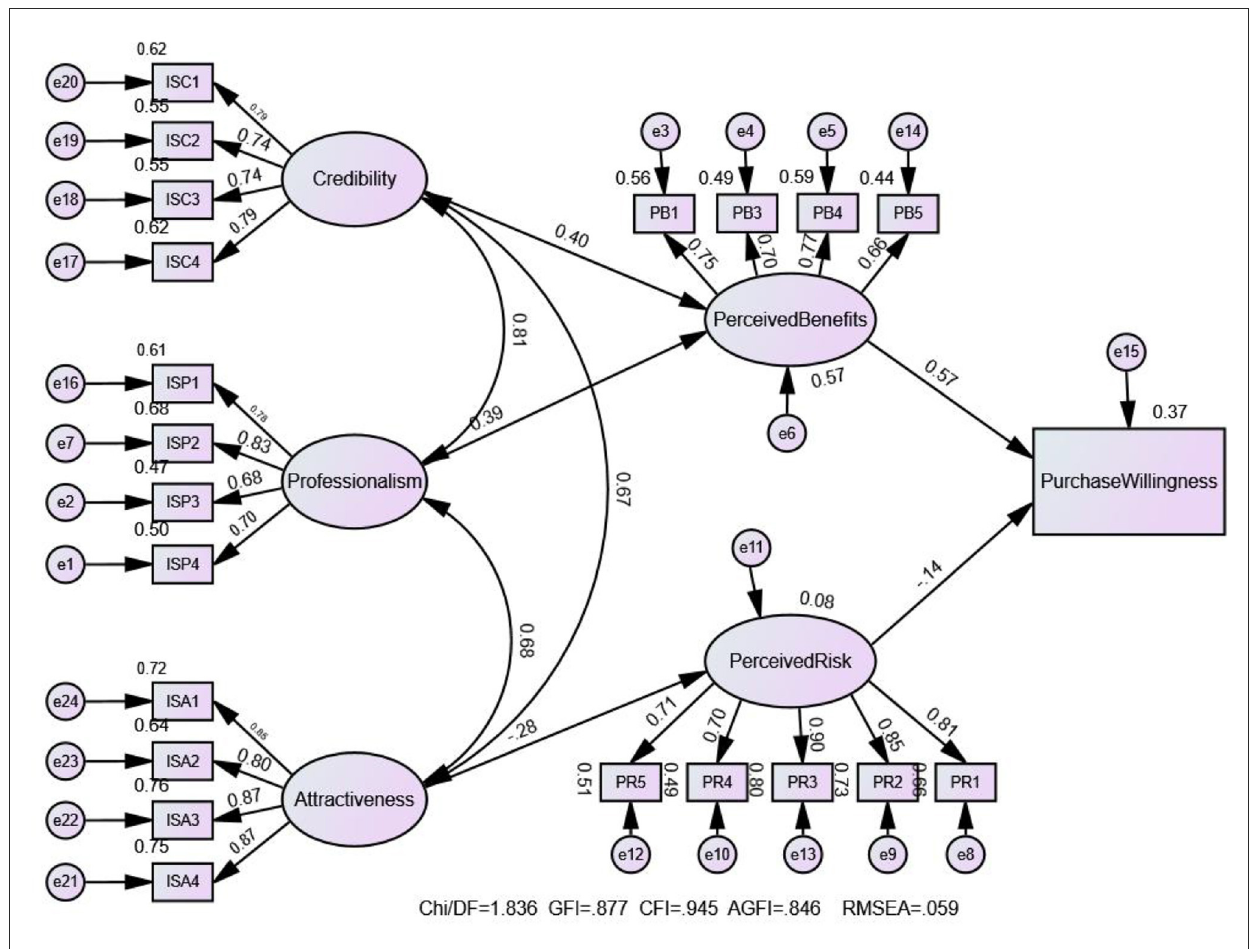
FIGURE2 Structural equation model analysis